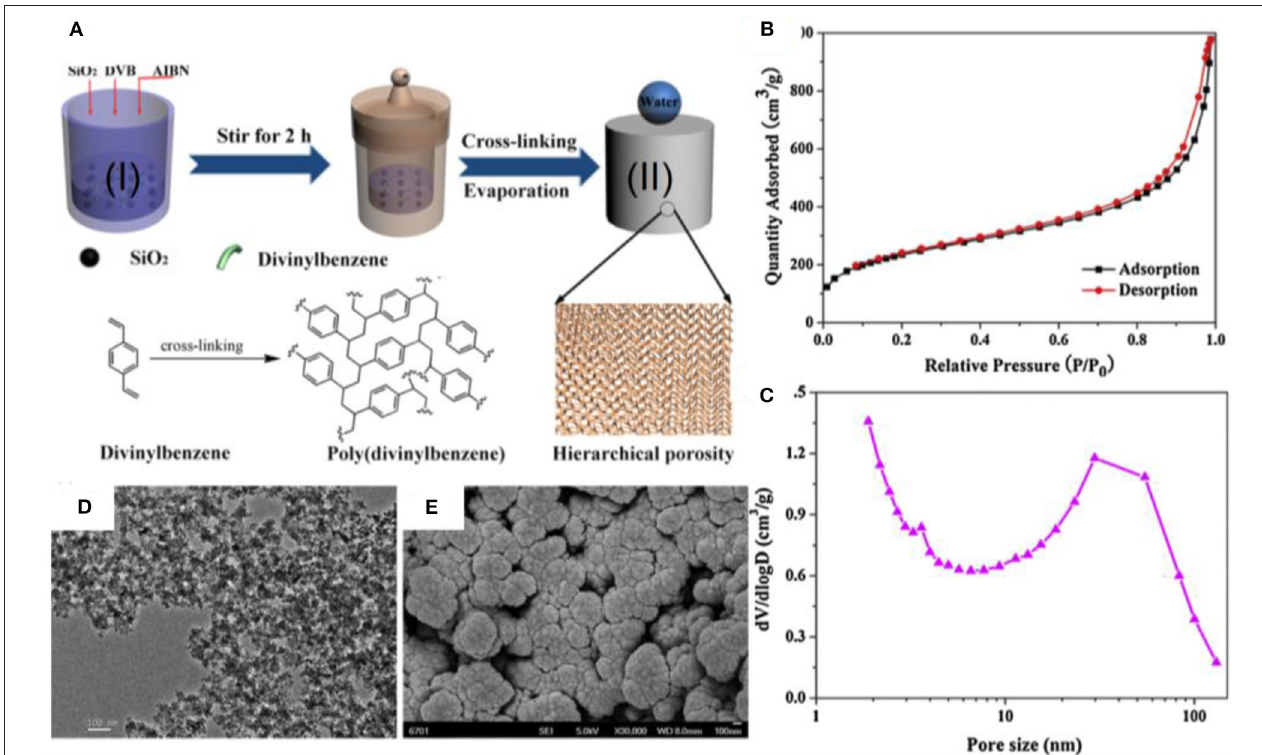
FIGURE 8 | (A) Schematic showing the fabrication process of hybrid material. (B) Gas adsorption isotherms and (C) pore size distribution confirm the nanoporous structure of hybrid material. (D) Transmission electron microscopy (TEM) images (E) and SEM images of hybrid material. Adapted from Li et al. (2017c). With permission from Elsevier, copyright 2017.